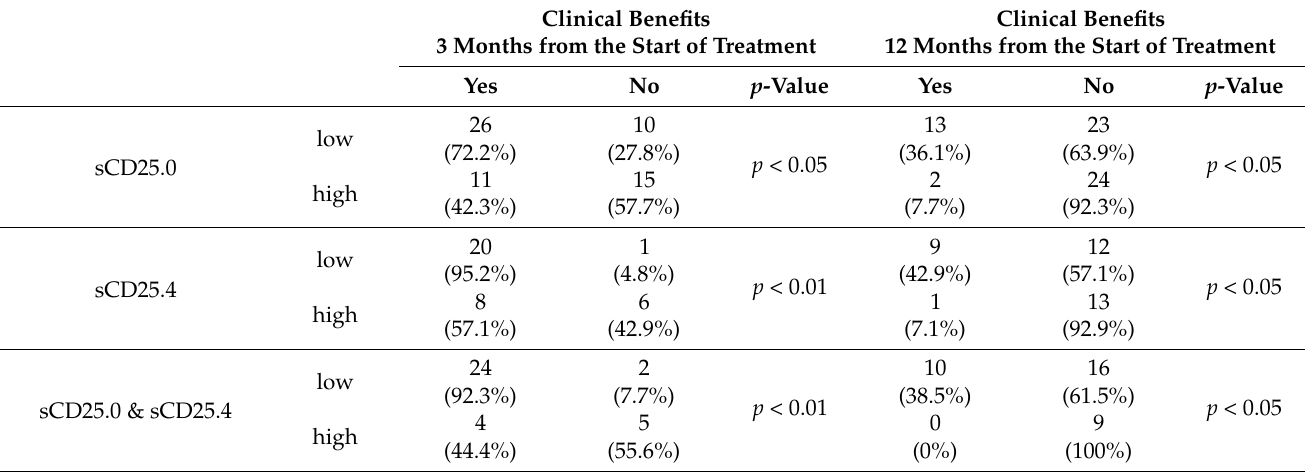
Table 2. Clinical benefits in NSCLC patients treated with ATEZO or PEMBRO. Clinical